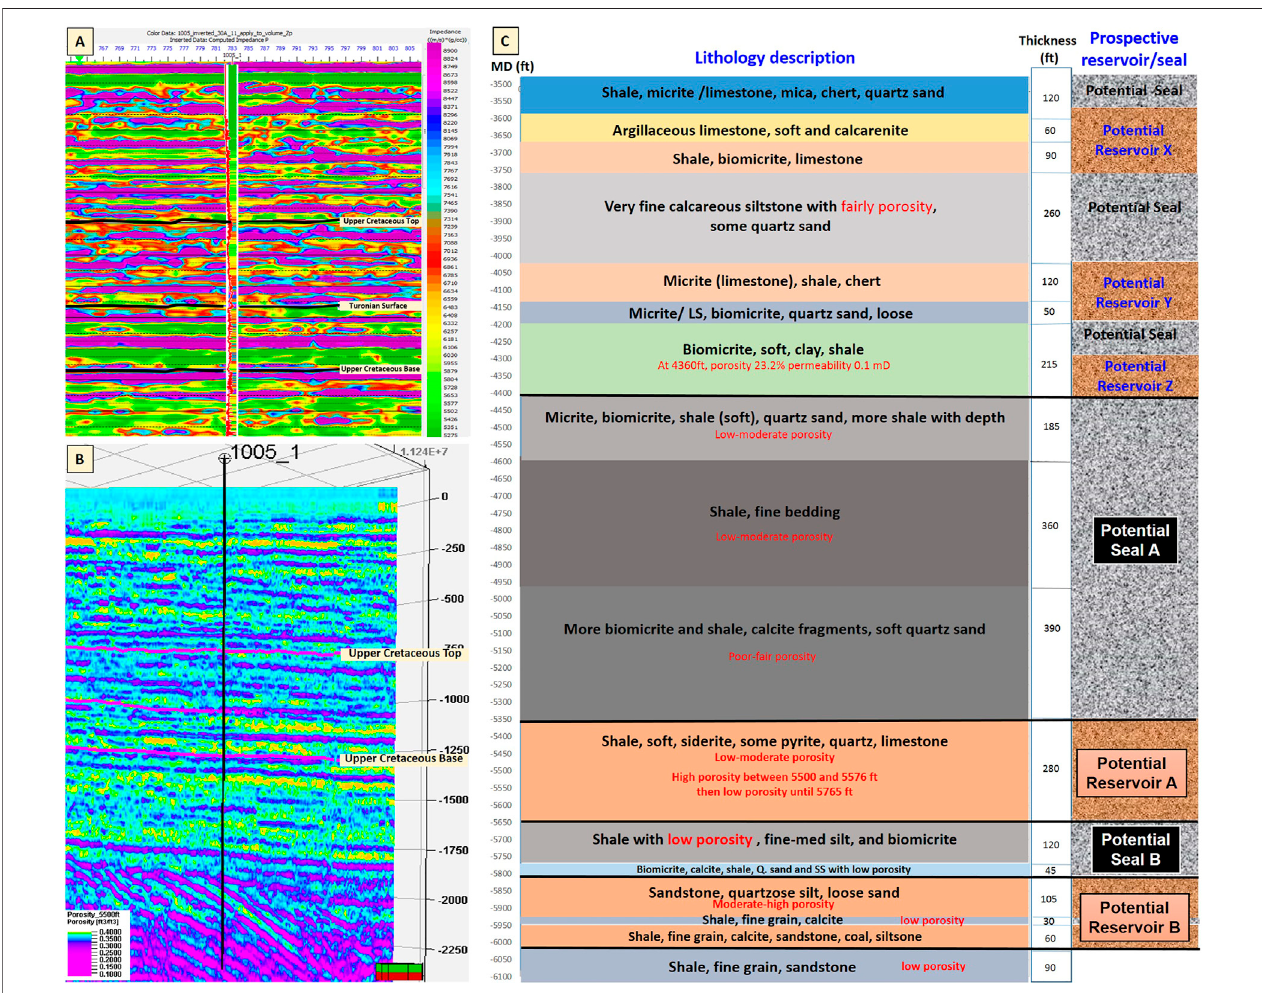
FIGURE14 | (A) Acoustic impedance, (B) extracted porosity, and (C) lithology description with ageological model for the two main potentials reservoirs and seals at the Upper Cretaceous strata at South Georgia embayment, modi fi ed after Almutairi et al. (2017); data from Scholle (1979).